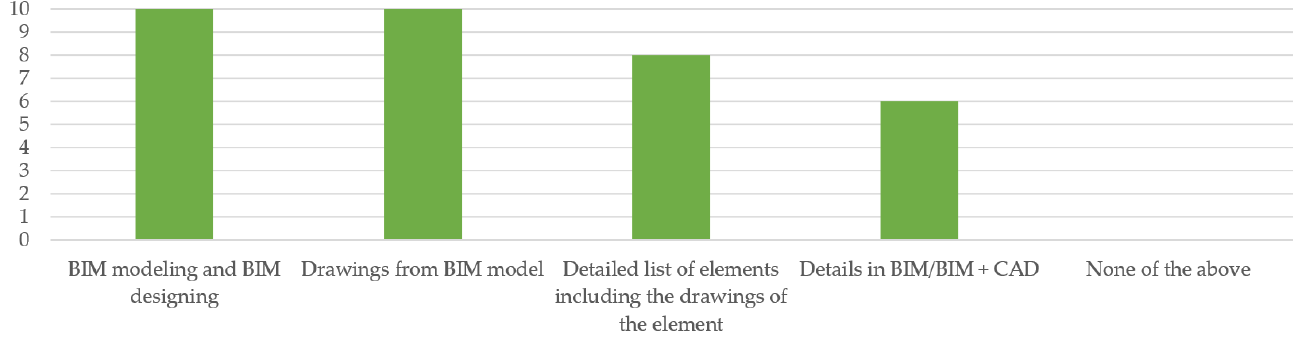
Figure 8. Responses to the question: “Which of the following tasks have been done by your team in the project? — part Creation of BIM models and project documentation”.